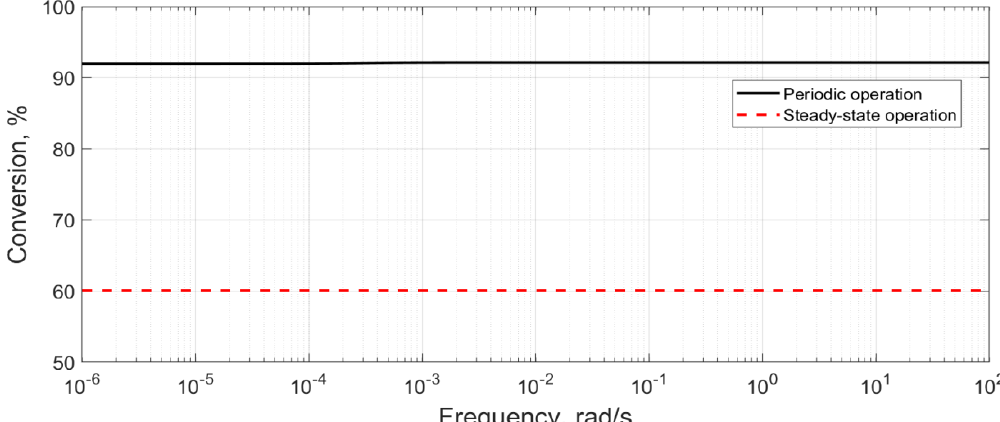
Figure 6. The highest acid conversion as a function of forcing frequency for simultaneous modulations of inlet volumetric flowrate and acid molar fraction (Case 5) around point SS5.